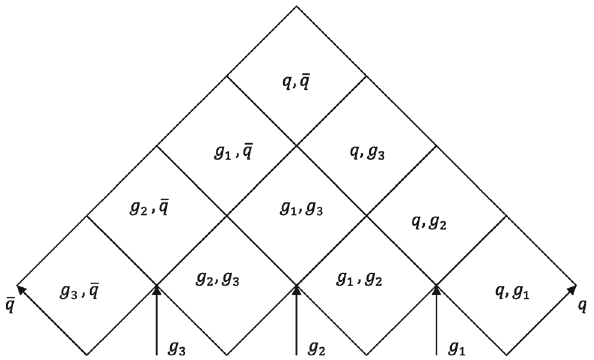
Fig. 11 Parameter plane for a five parton system